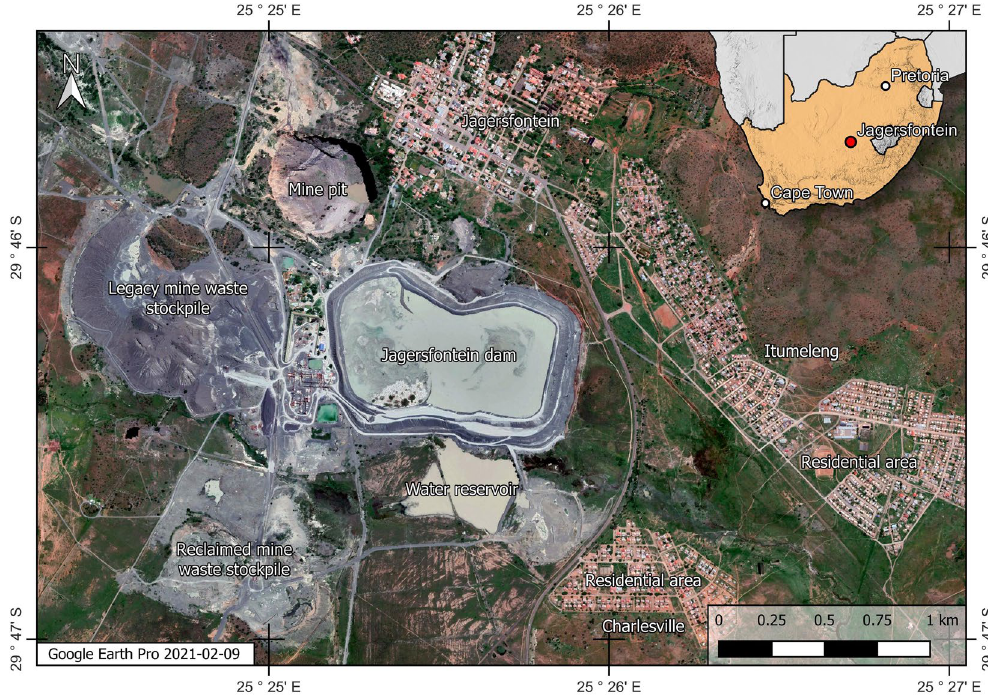
Figure 1. The Jagersfontein dam and its surroundings 19 months before failure, created using QGIS software version 3.26 (http:// www. QGIS.